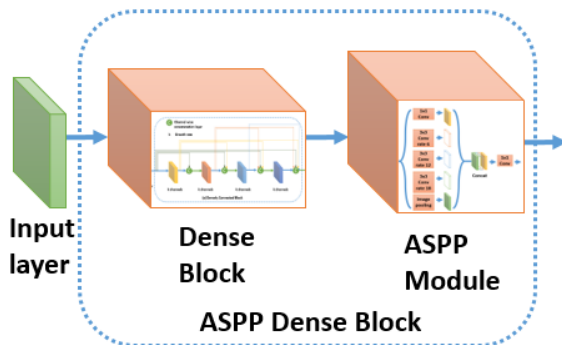
Figure 9. ASPP Dense